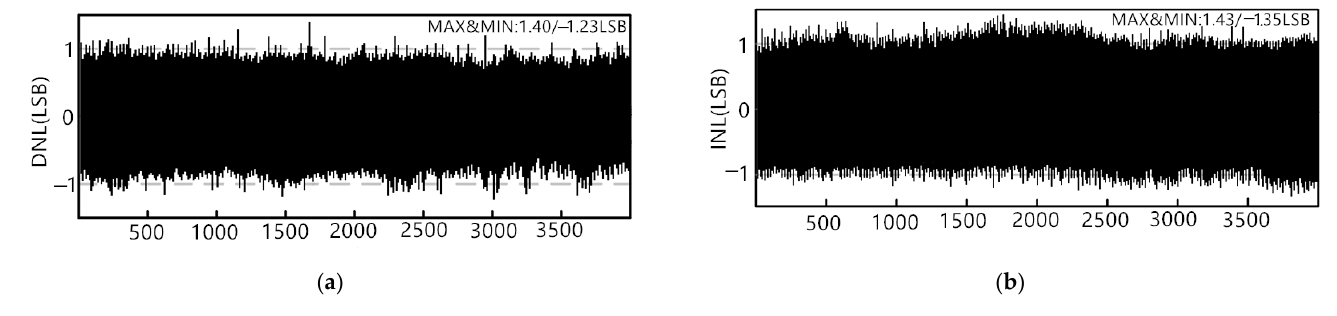
Figure 23. Measured DNL ( a ) and INL ( b ) when the proposed calibration method was off .